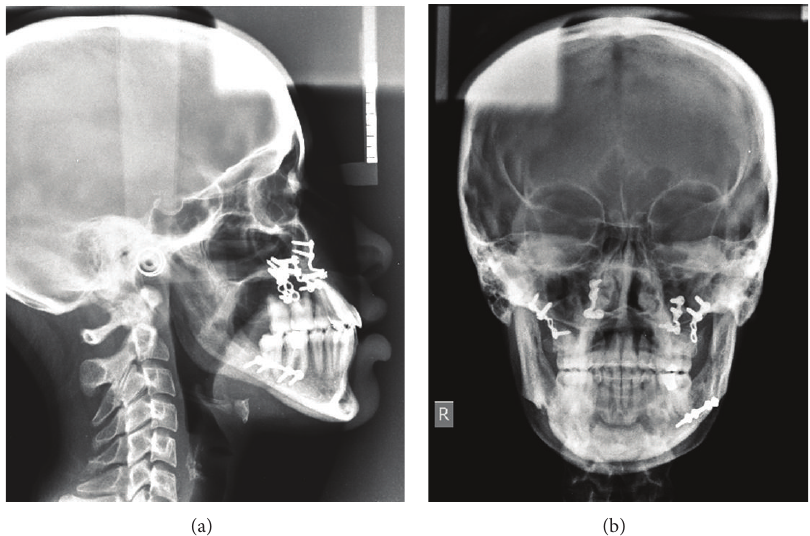
Figure 20: Posttreatment: (a) lateral, and (b) PA cephalograms.